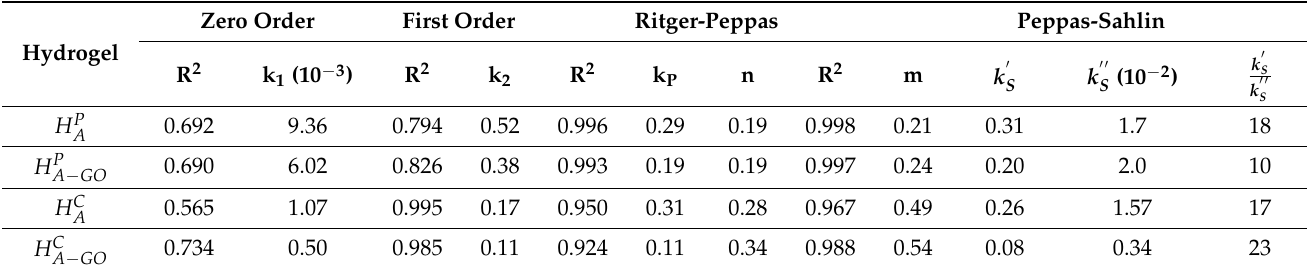
and H P ) and blank ( H C A − GO A − GO A